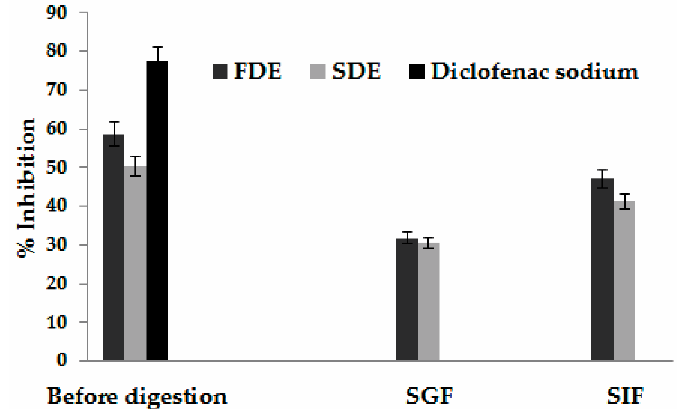
Figure 2. Anti-inflammatory activity of freeze-dried encapsulates (FDE) and spray-dried encapsulates (SDE) before and during simulated gastric (SGF) and intestinal fluids (SIF).